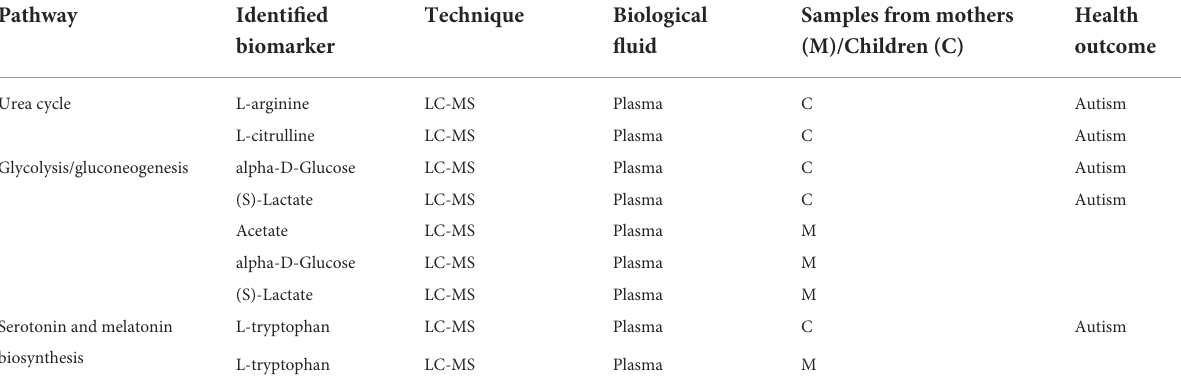
TABLE 4 Identified biomarkers and pathways related to neurodevelopmental adverse outcomes. Pathway